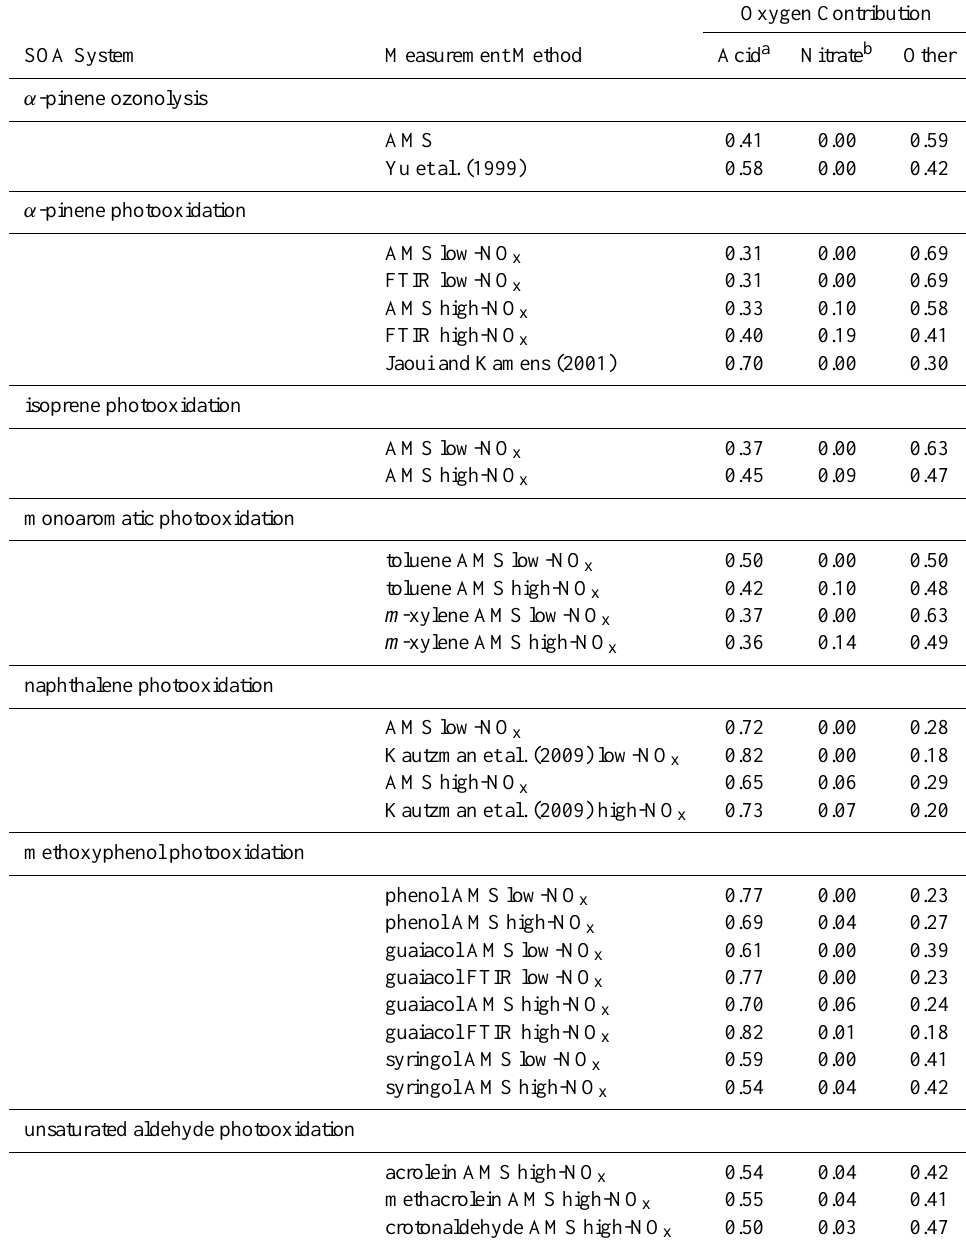
Table 2. Fraction SOA oxygen contribution in organic acid, organic nitrate, and other functionalities as measured by the AMS, FTIR, and speciation